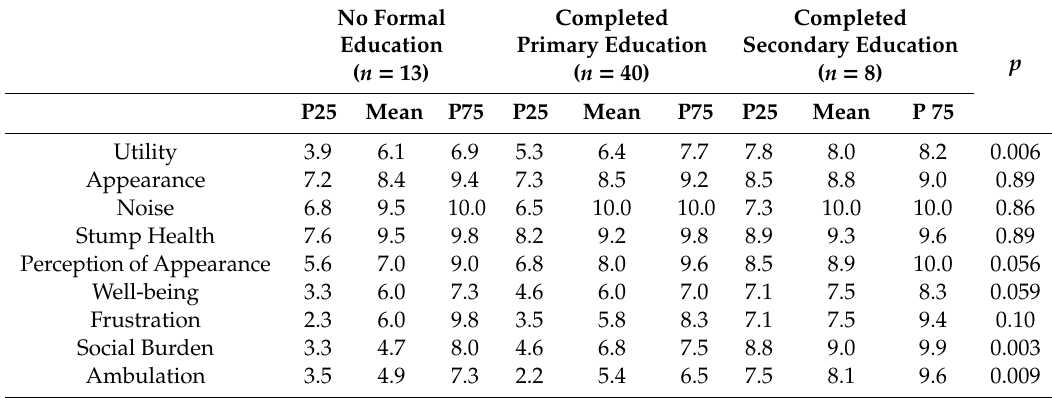
Table 6. PEQ domain levels in relation to educational